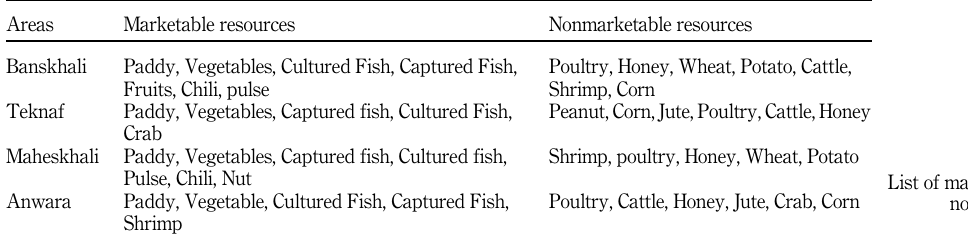
Table 3. List of marketable